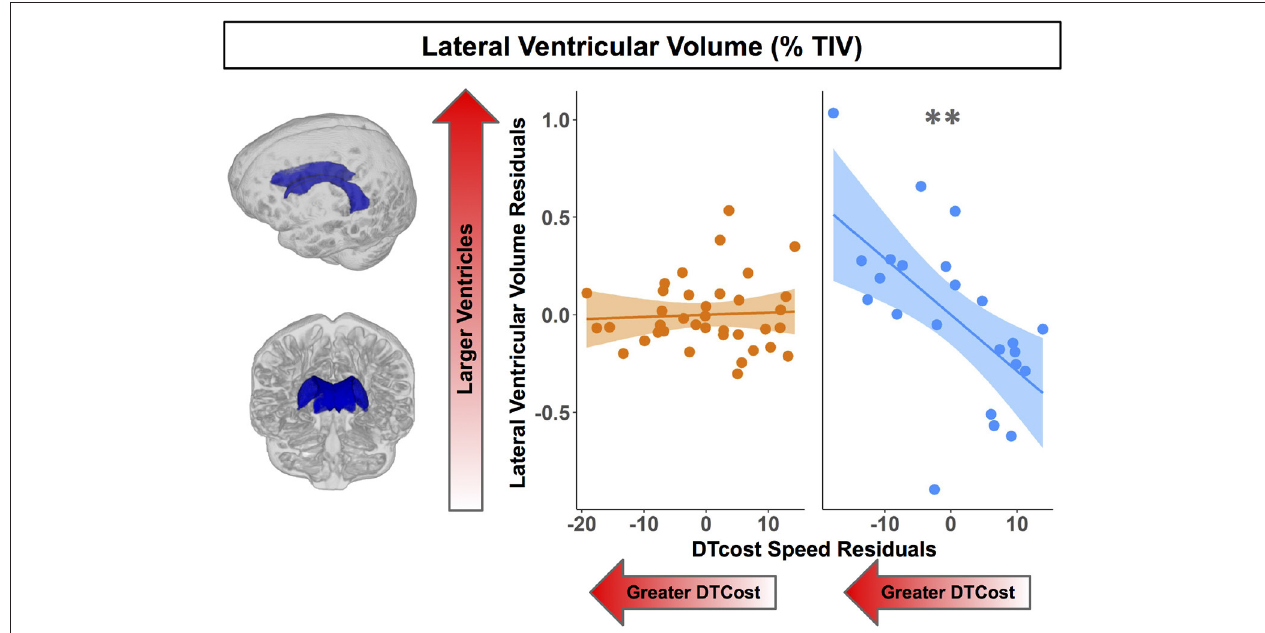
FIGURE 8 | Age differences in the relationship of lateral ventricular volume with the DTcost of gait speed. Left. Here we depict the lateral ventricular volume mask for a single exemplar participant overlaid onto that participant’s native space cerebrospinal fluid segment. Right. Lateral ventricular volume residuals (expressed as a percentage of total intracranial volume) are plotted against the DTcost of gait speed. We plotted the residuals instead of the raw values here to adjust for the effects of the sex covariate included in the model. ** p FDR − corr < 0.01.